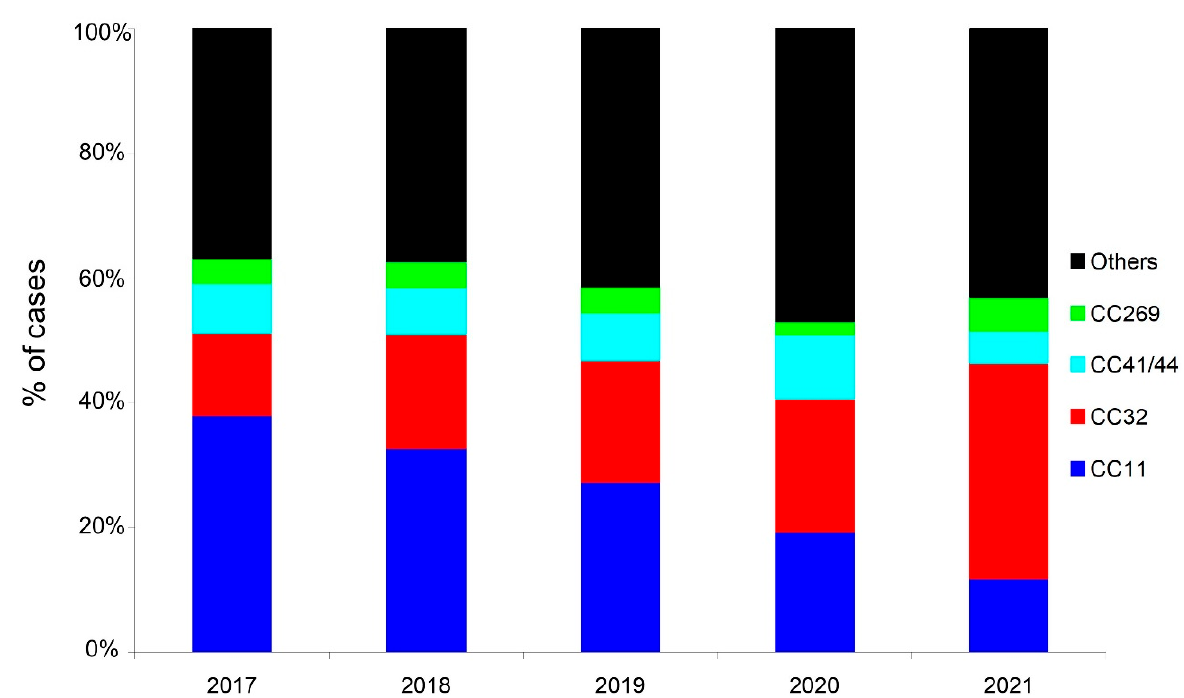
Figure 3. Evolution of cases of IMD in percentage per clonal complexes (indicated on the right).